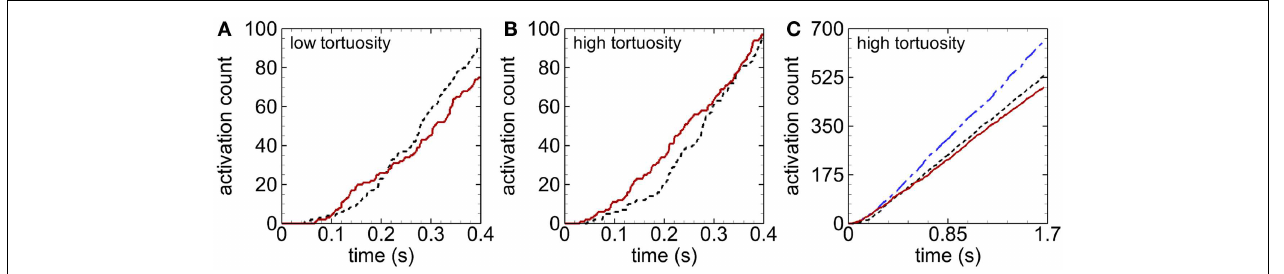
Seeding scenarios include whole-lumen-seeded platelets (dashed-dotted line), near-wall-seeded platelets (dashed line), and RBCs with platelets (solid line). Platelets are normal size.